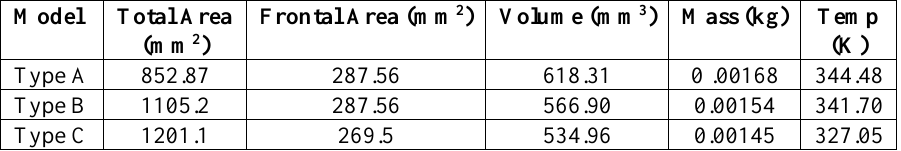
Table 4: Average Temperature and mass for various heat sink designs at 𝑞̇ = 190 0 𝑊/𝑚 2 .